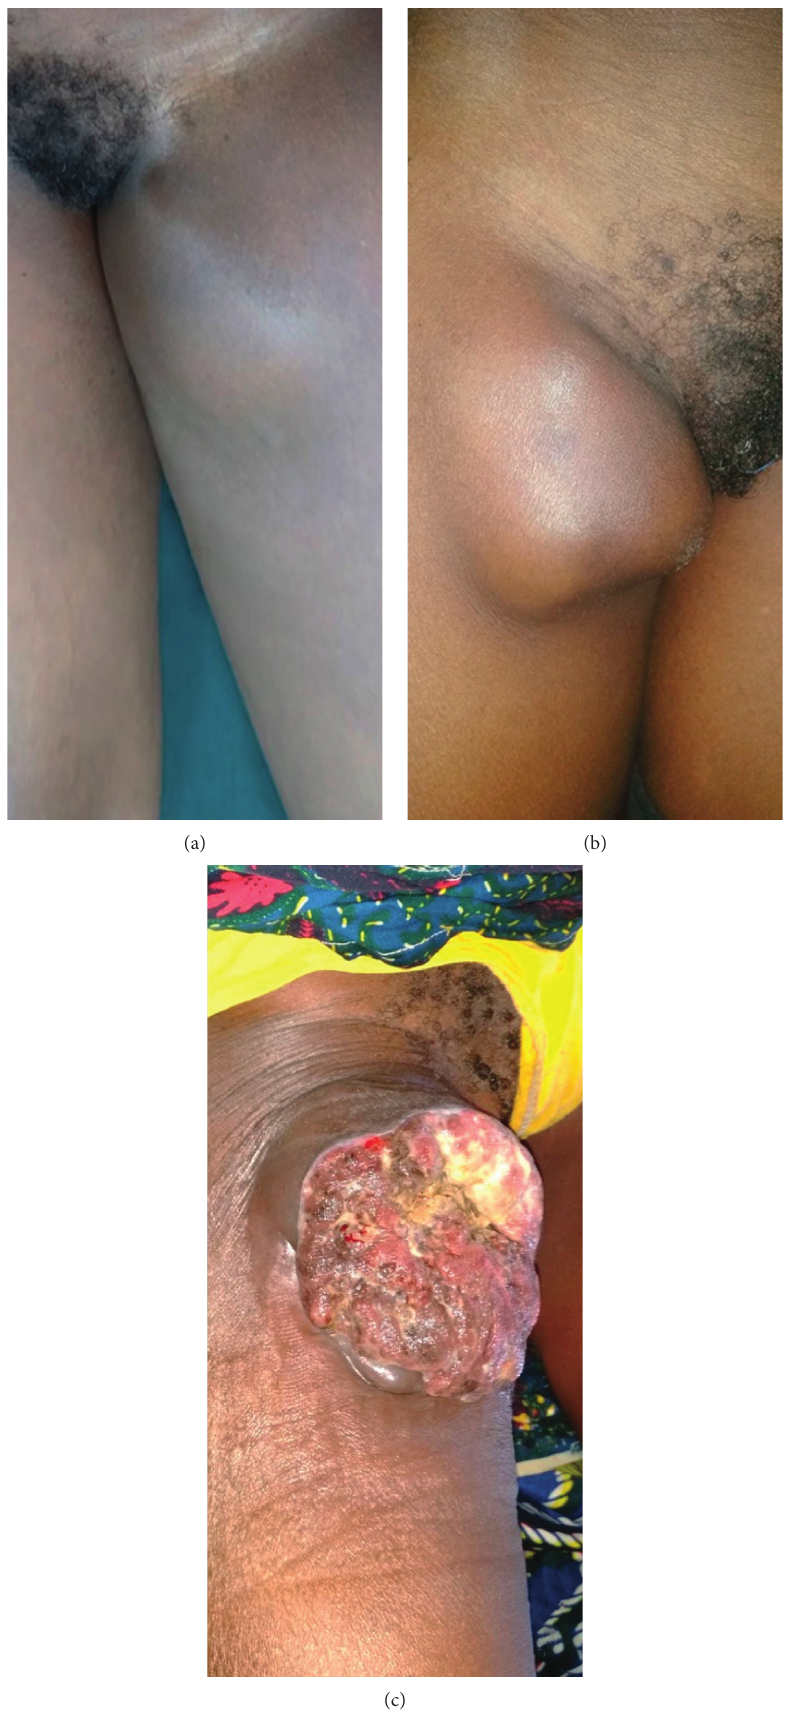
Figure 2: Inguinal metastasis lymphadenopathies aspects. (a) Palpable lymphadenopathy, (b) visible lymphadenopathy, and (c) ulcerous